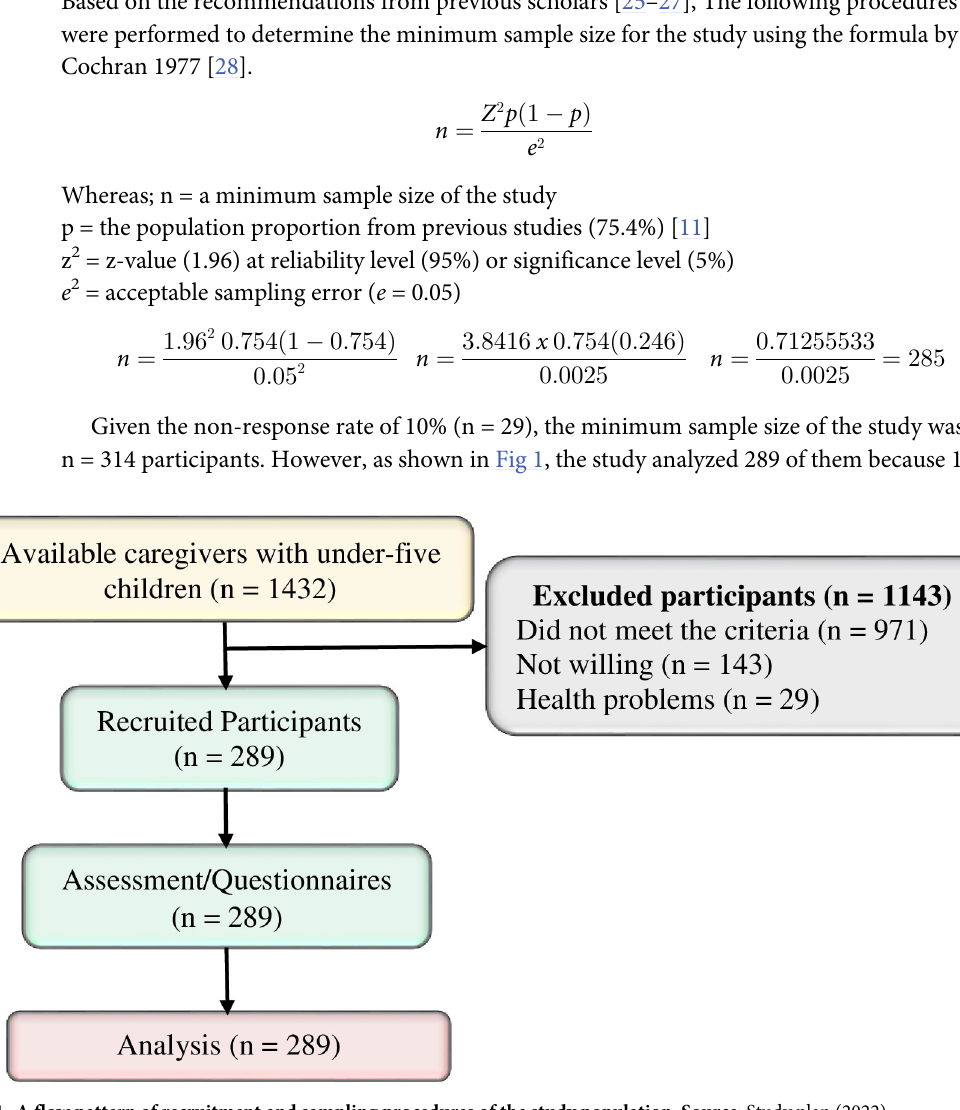
Fig 1. A flow pattern of recruitment and sampling procedures of the study population. Source : Study plan (2022).